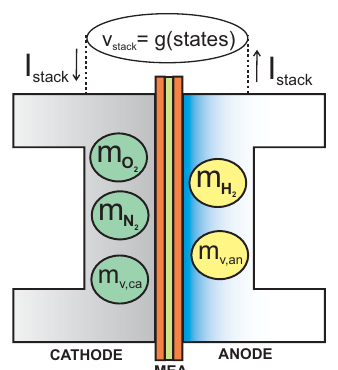
Figure 4. Modeling approach: three states in CA, two states in AN, with stack output voltage defined as a nonlinear function of all five states, while the stack current is treated as a disturbance.